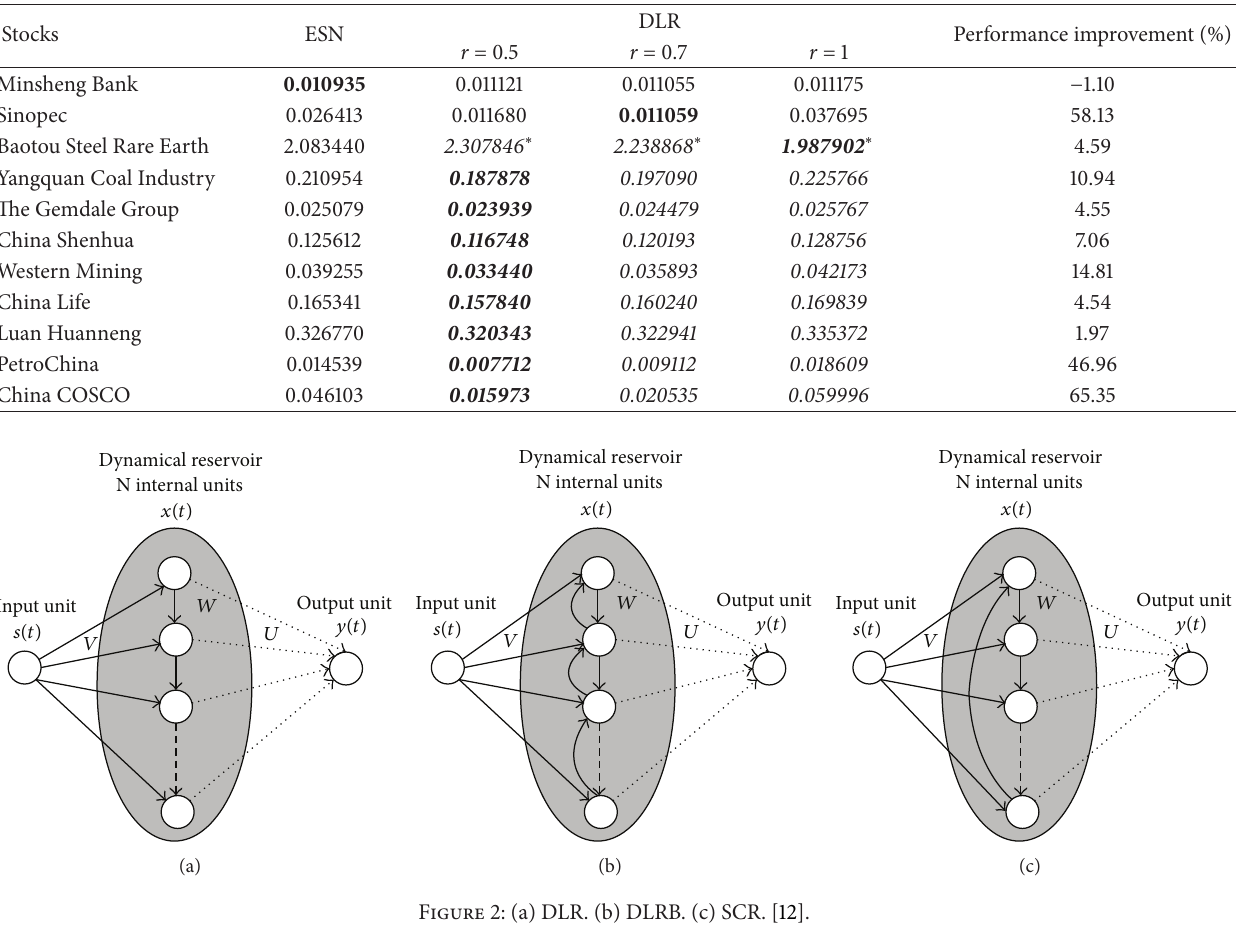
Table 1: Comparative results of ESN and DLR by average forecasting accuracy (MSE).